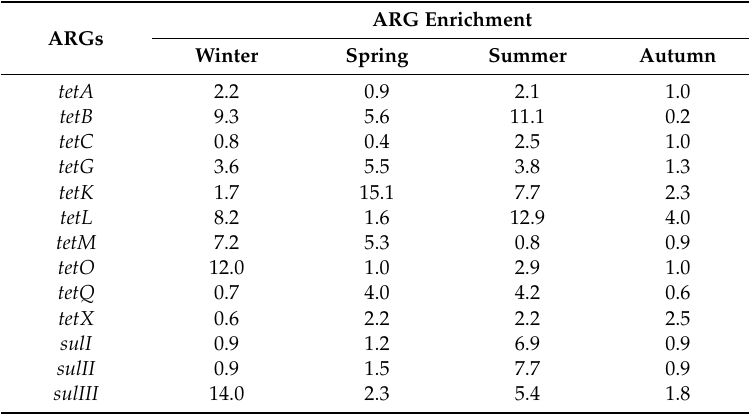
Table 2. Results of comparative qPCR analysis for